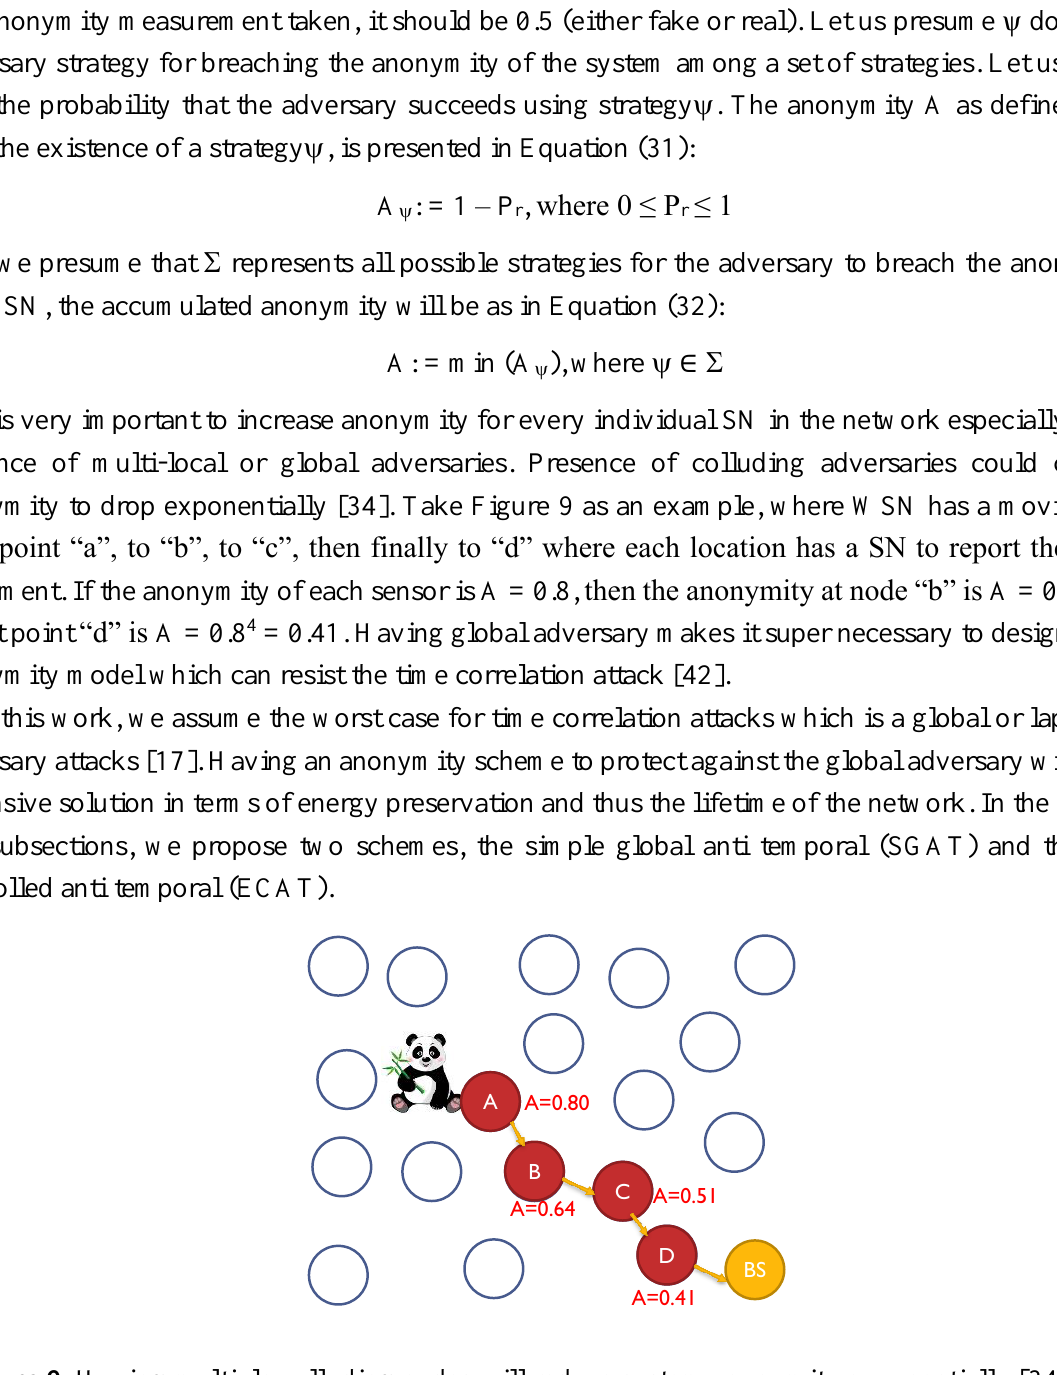
Figure 9. Having multiple colluding nodes will reduce system anonymity exponentially